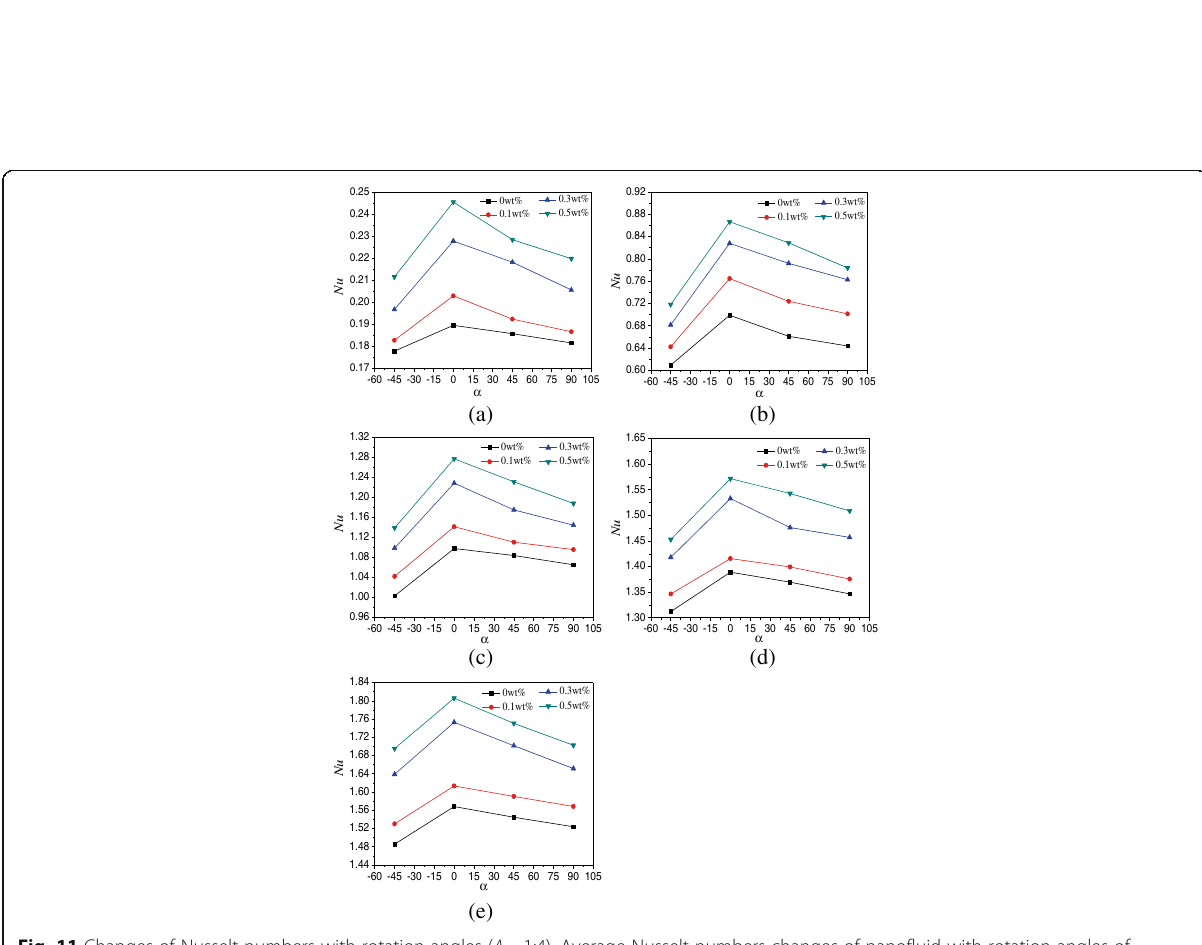
Fig. 11 Changes of Nusselt numbers with rotation angles ( A = 1:4). Average Nusselt numbers changes of nanofluid with rotation angles of enclosure ( A = 1:4) at different heating powers. a Q = 1 W. b Q = 5 W. c Q = 10 W. d Q = 15 W. e Q = 20 W